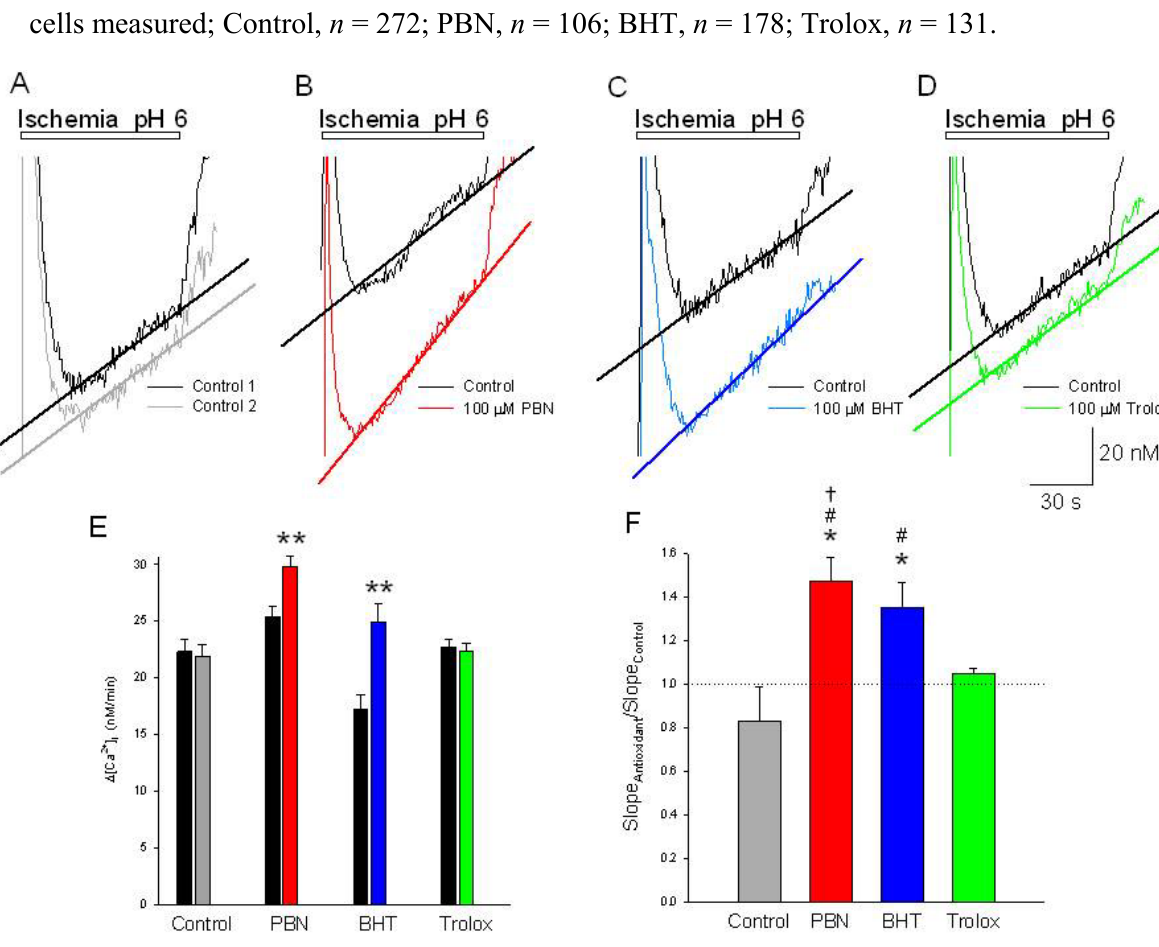
Figure 4. The rate of [Ca 2+ ] , increases in response to acidic ischemia are potentiated by i , increases as PBN and BHT. Expanded, representative traces of the second phase of [Ca 2+ ] i a function of time during a ( A ) 2 min application of glucose-free PSS pH 6.0 with 4 mM NaN (black trace). Following a 20 min washout, a second application of acidic ischemia 3 increase (grey trace); Straight lines are induces an approximately equal rate of [Ca 2+ ] i linear fits to the data. In separate experiments, following the control acidic ischemia application (black traces), cells were incubated for 20 min in ( B ) 100 μ M PBN or ( C ) 100 μ M BHT prior to a second acidic ischemia insult which produced rates of increase in [Ca 2+ ] greater than control values (red and blue traces, respectively). Incubation in 100 μ M i trolox ( D ) had no effect on the rate of increase in [Ca 2+ ] compared to control (green trace); i increases from experiments ( E ) Summary of measurements of the slopes of [Ca 2+ ] i identical to ( A – D ) expressed as means ± S.E.M.. Black bars represent slopes measured from initial control responses and color bars represent slopes from subsequent responses in the absence (gray) and presence of the antioxidants. ** p < 0.001, compared to control by student t -test; ( F ) Slopes measured from second responses to acidic ischemia recorded in the absence and presence of the three antioxidants were normalized to slopes measured from initial control responses and expressed as means ± S.E.M. One way ANOVA comparison was performed on ratios of test responses/control responses. * p < 0.5 compared to control, # p < 0.5 compared to trolox, † p < 0.5 compared to BHT. Number of cells measured; Control, n = 272; PBN, n = 106; BHT, n = 178; Trolox, n =